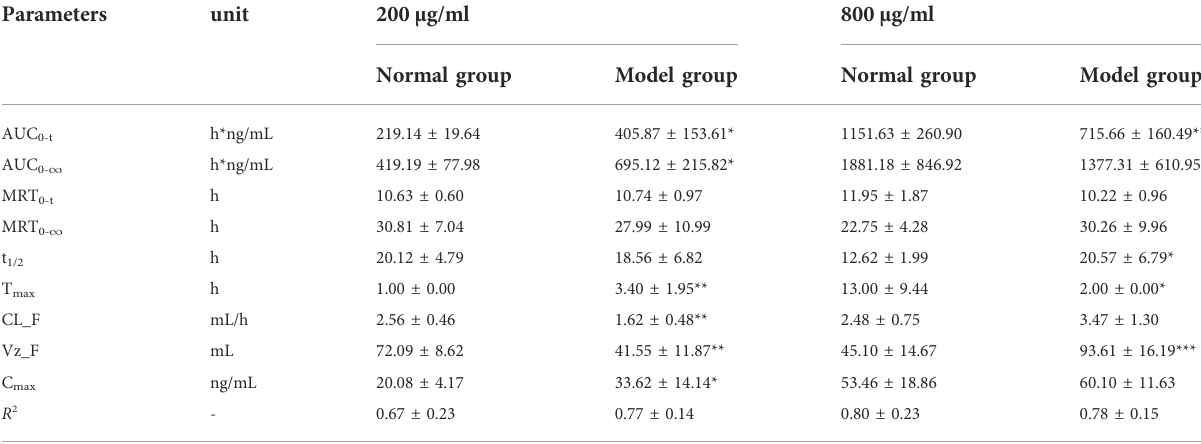
TABLE 3 The pharmacokinetic parameters of chlorogenic acid in RAW264.7 cells after treatment with 200 μ g/ml and 800 μ g/ml of I. cappa extracts ( (cid:1) x ± SD, n = 6).